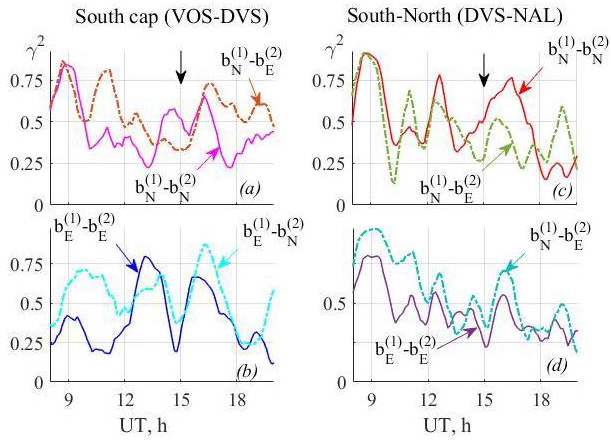
Figure 12. Time variations in average spectral coherence in the 1.2– 1.9mHz frequency band between two points in the southern polar cap and between the southern and the northern polar cap stations: The coherence of the corresponding components (NN and EE) is shown in all panels using solid lines, and the cross-component (NE and EN) coherence is shown using dot-dashed lines. The upper in- dexes indicate the number of a station in the station pair. The times at which there is a decrease of the spectral power of the pulsations at Cluster are marked with an arrow.